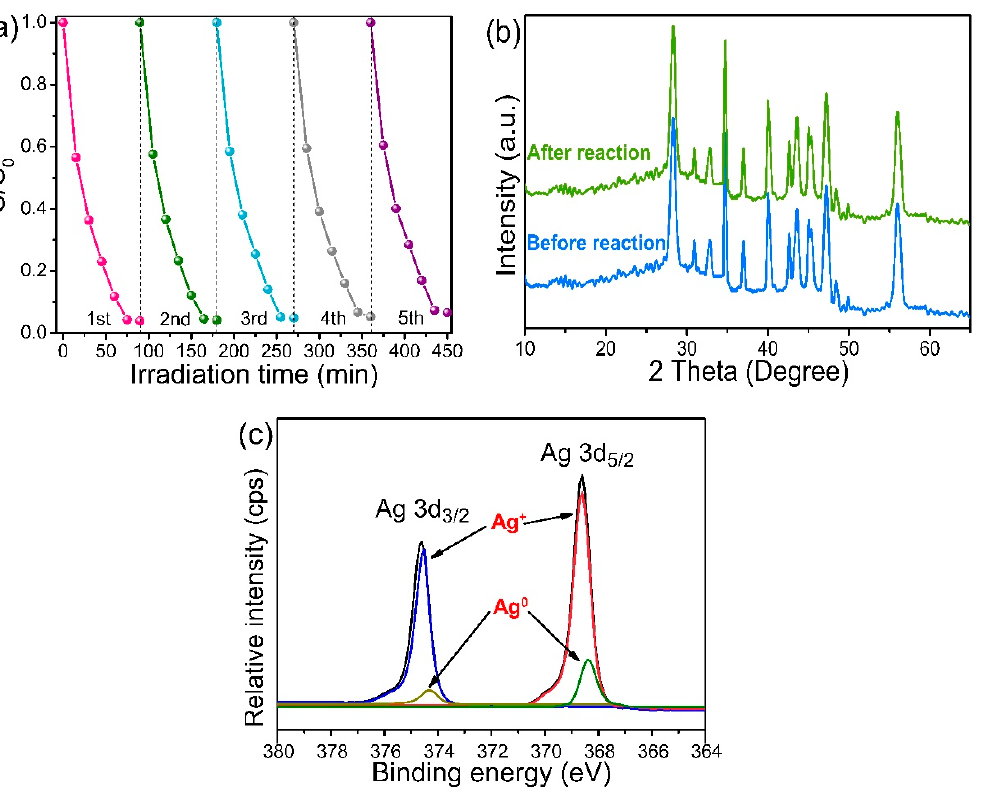
Figure 12. ( a ) Cycling experiments for photo-electrocatalytic degradation on TC by 10% CeO 2 QDs / Ag 2 Se, ( b ) XRD, and ( c ) Ag 3d XPS spectra of 10% CeO 2 QDs / Ag 2 Se after five photo-electrocatalytic degradation cycles.